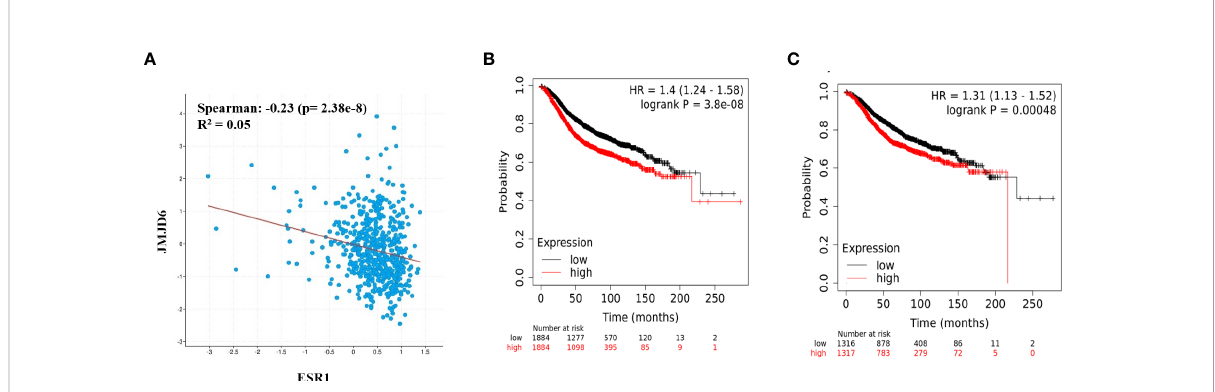
FIGURE 4 JMJD6 and ER in breast cancer patient samples. (A) Correlation between JMJD6 and ESR1 in ER+ breast cancer patient samples from TCGA data set. Kaplan-Meier survival curves plotted using the ratio of JMJD6/ESR1 RNA expression (n=3768) (B) , and ratio of JMJD6/ER proteins (n=2633) (C) in ER+ breast cancer